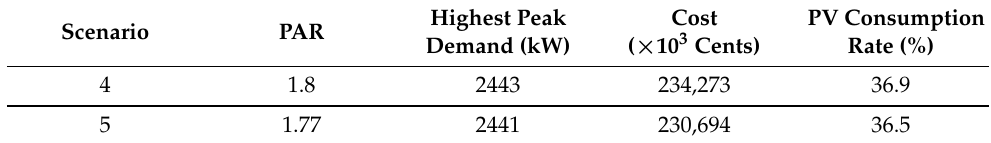
Table 4. Comparison of obtained performances under different schemes in case 2.